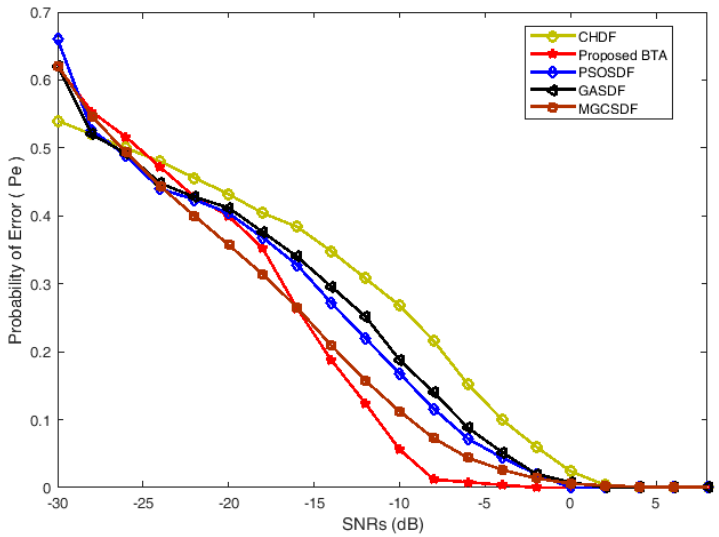
Figure 4. Probability of error vs. signal-to-noise ratios (SNRs) under normal cooperative users.